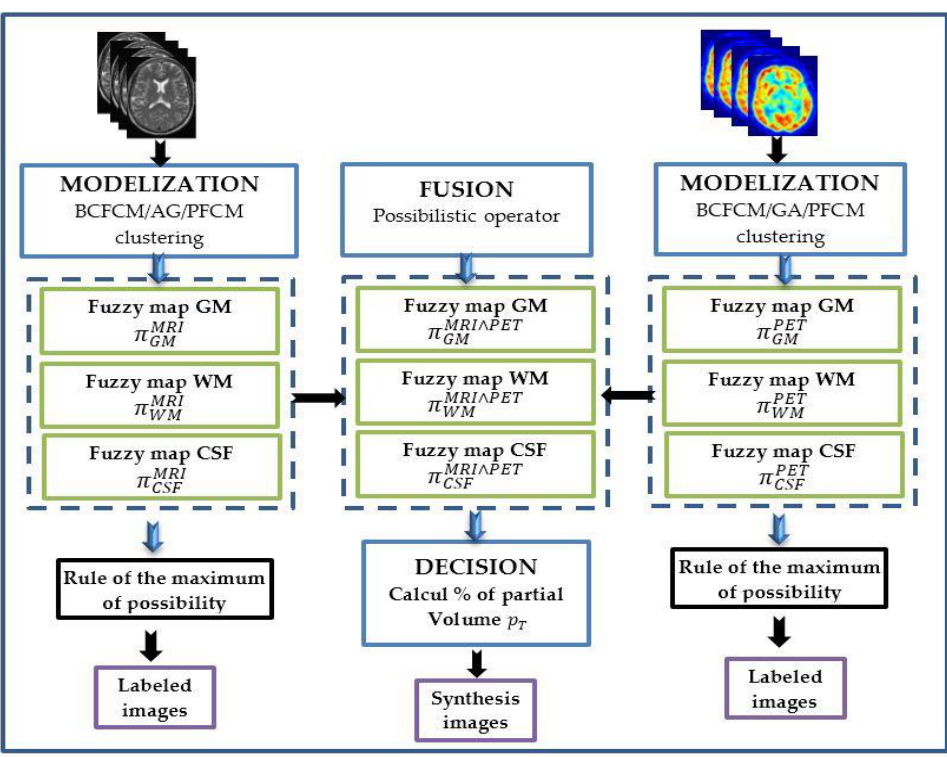
Figure 2. Proposed general scheme for tissue quantification based on multimodal MRI / PET fusion based on modeling, fusion and decision steps.